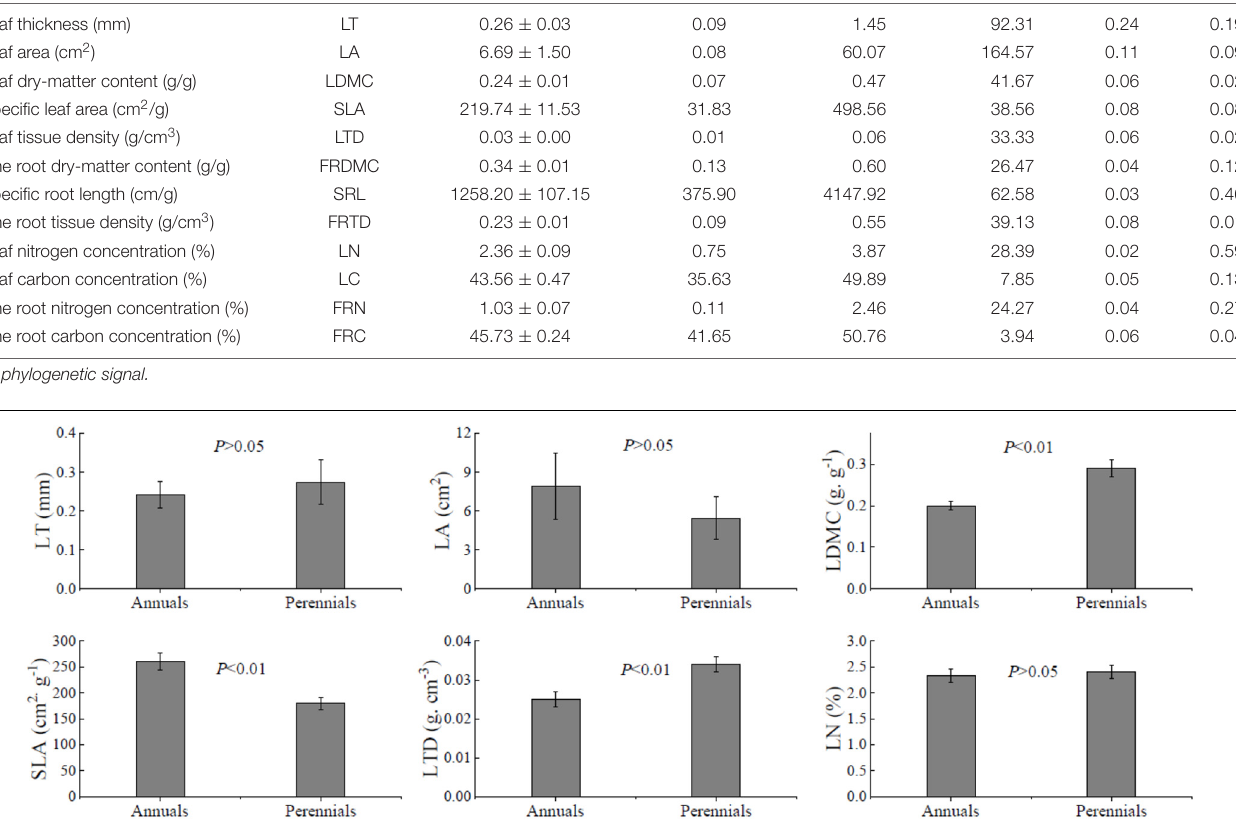
TABLE 1 | Traits of leaf and fine root of 54 dominant species in Horqin Sandy Land and their phylogenetic signal ( K ). Traits Traits Mean ± SE Minimum Maximum